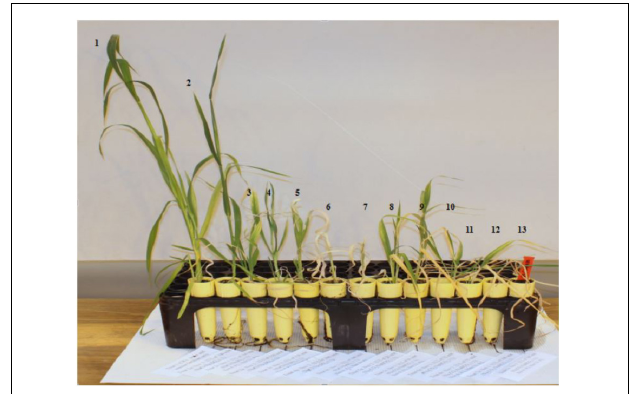
FIGURE 7 | Plant height of a single genotype under varied salt and alkali stresses. 2–7, salt stress; 8–13, alkali stress. 1, Control; 2 and 3, oat under l00 mmol L − 1 salt stress; 4 and 5, oat under 150 mmol L − 1 salt stress; 6 and 7, oat under 200 mmol L − 1 salt stress; 8 and 9, oat under 50 mmol L − 1 alkali stress; 10 and 11, oat under 75 mmol L − 1 alkali stress; 12 and 13, oat under l00 mmol L − 1 alkali stress.